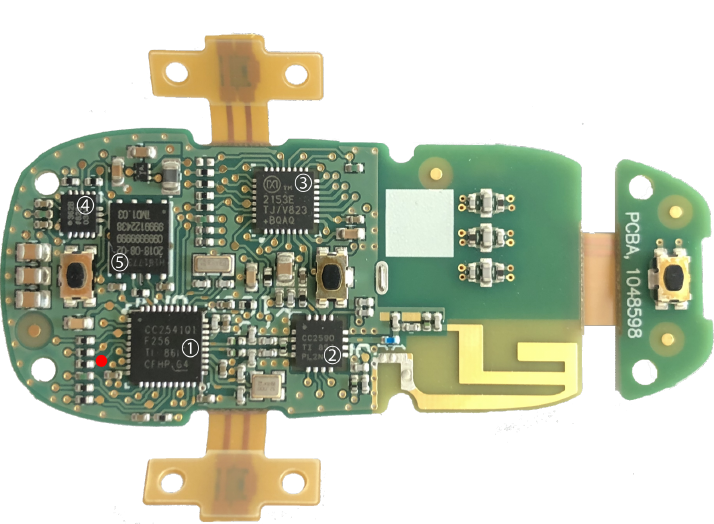
Figure 1: The Model X key fob PCB (top side). The main components are: (1) Texas Instruments CC2541 BLE SoC, (2) TI CC2590 BLE range extender, (3) Maxim Integrated MAX2153E 22 kHz transponder, (4) Analog Devices ADXL362 MEMS accelerometer